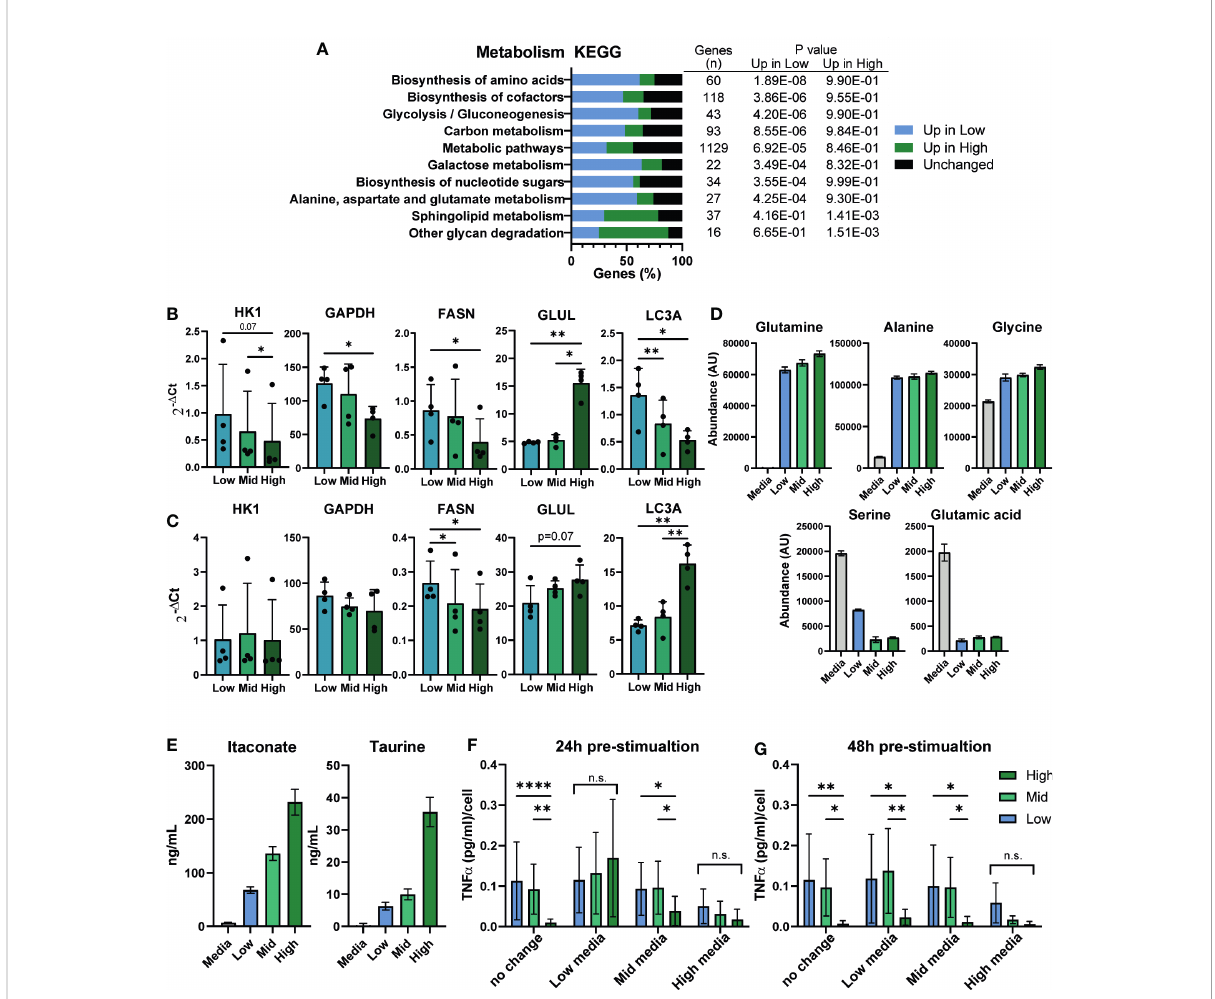
FIGURE 5 Macrophage density is linked to altered metabolism and the extracellular environment may suppress in fl ammation. (A) Metabolism related KEGG term analysis of differential gene expression comparing high vs low density plated iPSC-Mac. Bars indicate proportion of genes in a given term that are upregulated at each density or unaffected. Number of genes per term, and P value for enrichment at each density are shown in the adjoining table. (B, C) qPCR for metabolism related genes in a second iPSC line (B) unstimulated or (C) LPS/IFN g polarized likely indicates broad metabolic differences between densities. n=4, signi fi cance for all genes calculated simultaneously by two-way ANOVA, Tukey ’ s multiple comparisons test with Greenhouse-Geisser correction. (D) Comparison of extracellular amino acid concentrations measured by LC-MS show limited differences between densities compared to a fresh medium control. Abundance has been calculated by area under the curve of the total ion chromatogram (TIC) peaks. (E) Concentration of the two immunosuppressive metabolites itaconate and taurine in the supernatant. (D, E) n=6 technical replicates. (F, G) Supernatant exchange between densities suggests a key role in regulating the density dependent in fl ammatory response. Media exchanged between densities (F) 24 hours pre-stimulation (day 6 of differentiation) or (G) 48 hours pre-stimulation (day 5)